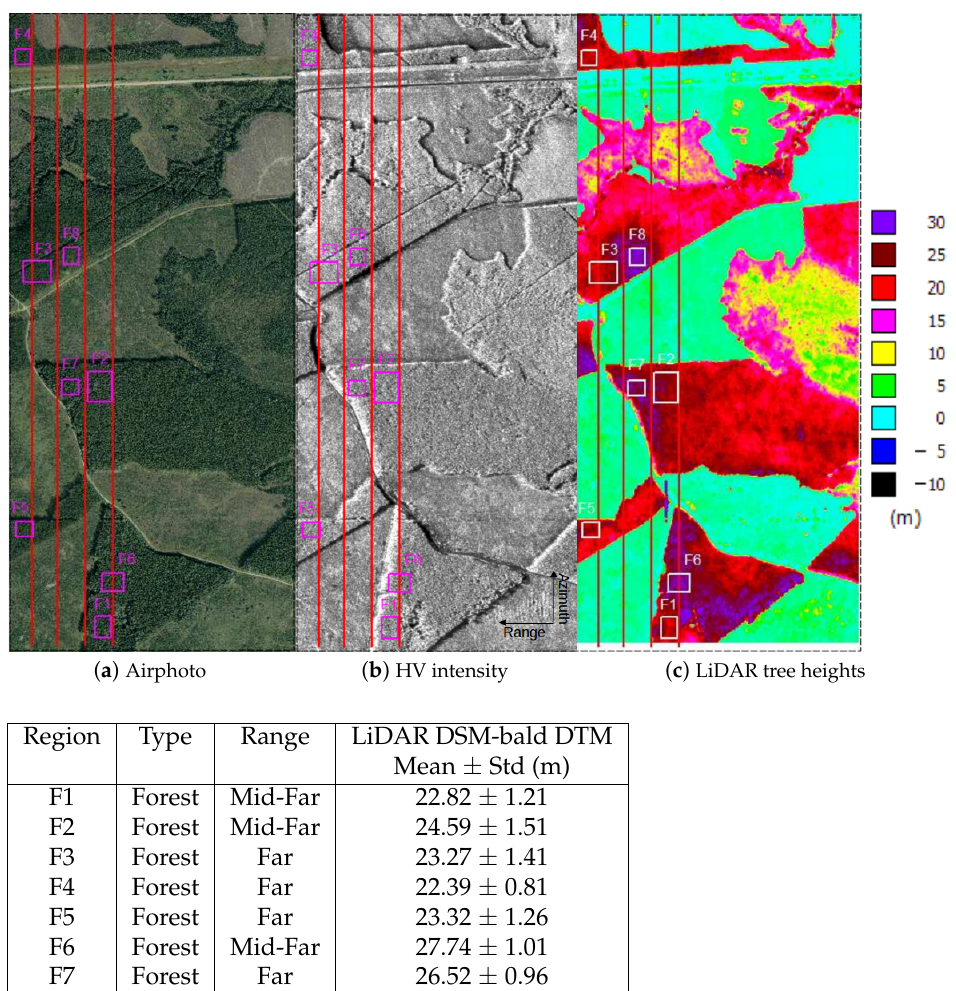
Figure 2. LiDAR-derived tree heights over Edson (courtesy Terrapoint